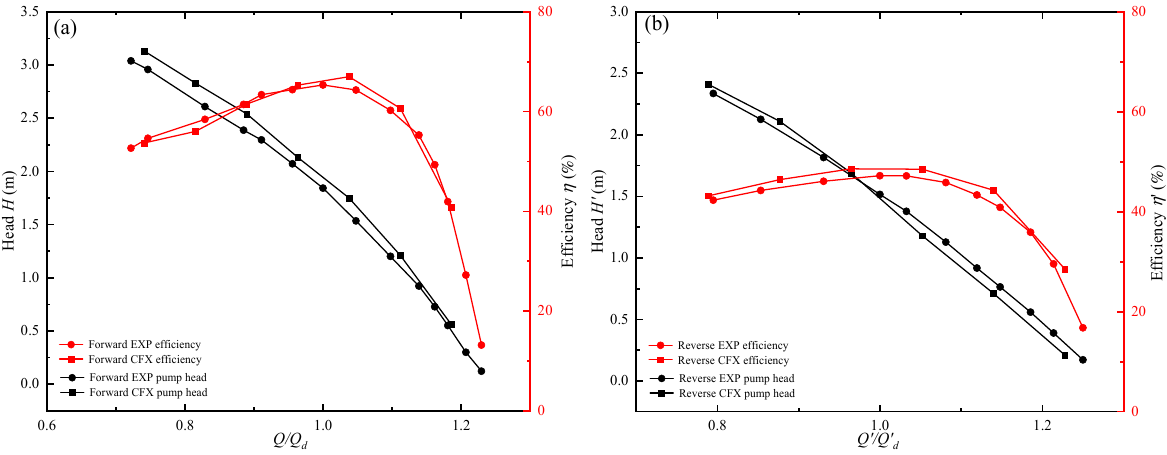
Figure 9. Comparison between numerical and experimental results of the pump for blade angle β = 0° in: ( a ) forward operation; ( b ) reverse operation.